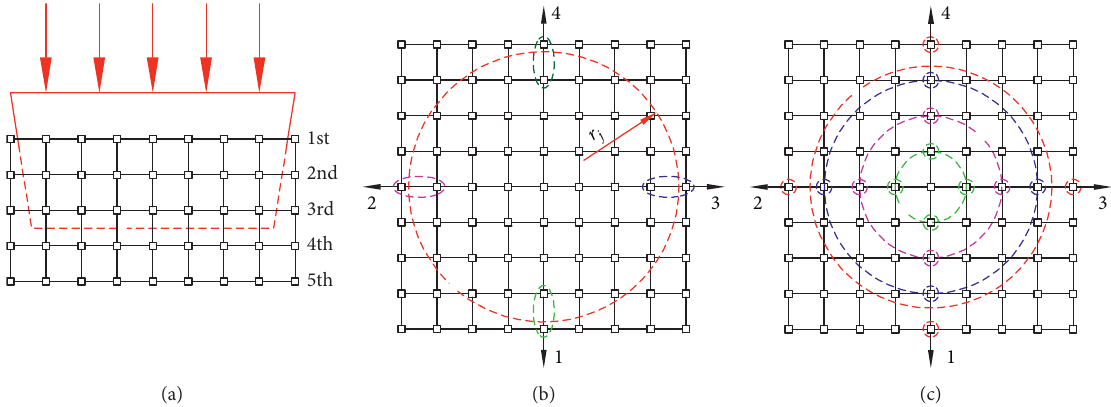
Figure 11: Grid mesh and node selection around the pin surface in the plunge stage in the MAM. (a) Division of elements and nodes; (b) node selection around the pin side; (c) node selection around the pin tip.